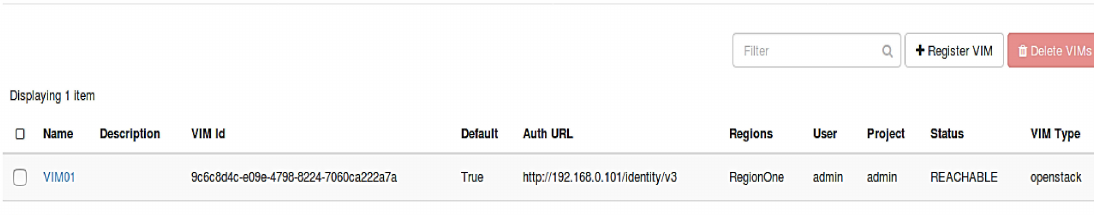
Figure 6. Creation of Virtualized Infrastructure